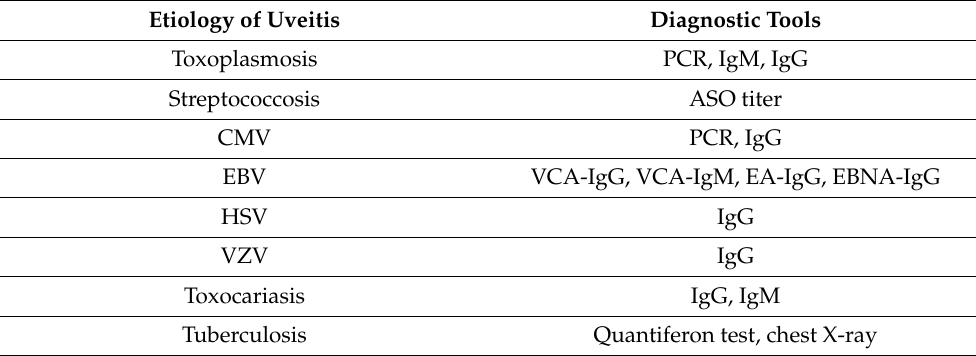
Table 1. Diagnostic tests used in infectious